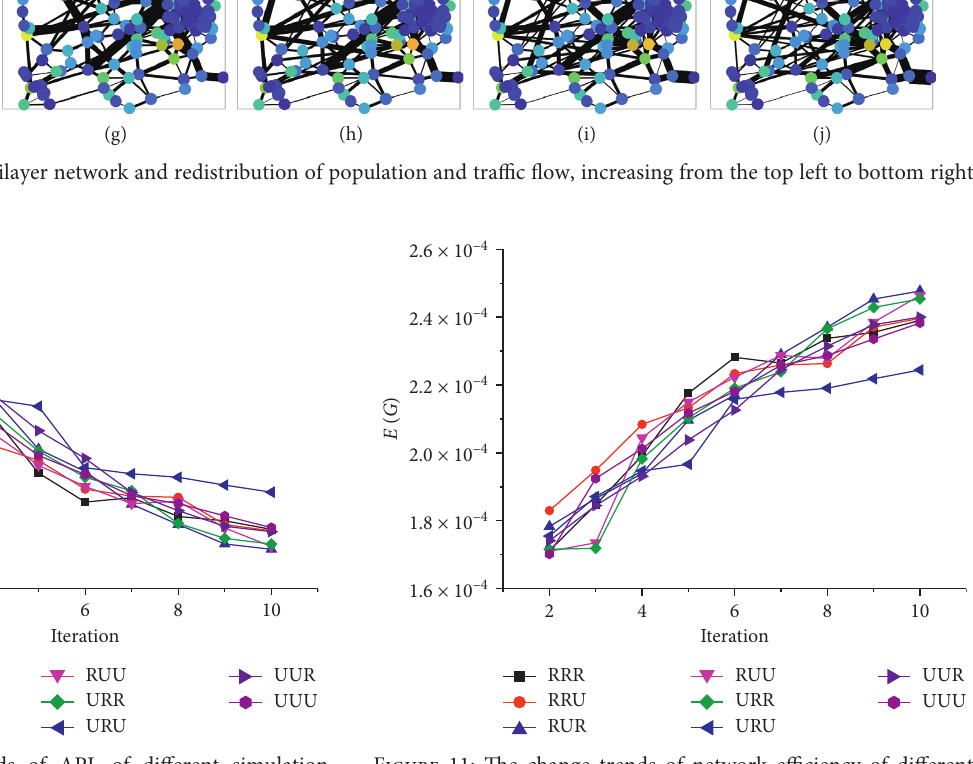
Figure 9: The change trends of APL of different simulation scenarios.